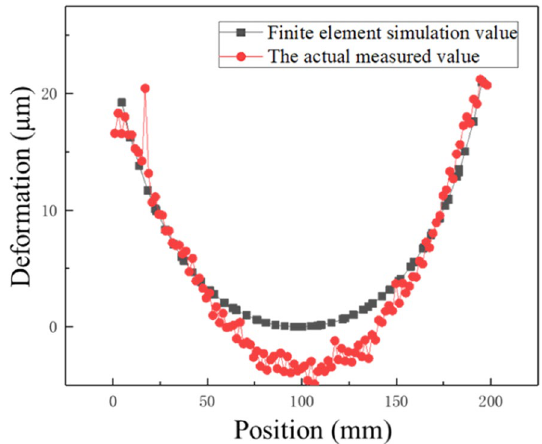
Figure 13 Measurement results of workpiece deformation with uneven material removal of upper and lower surfaces